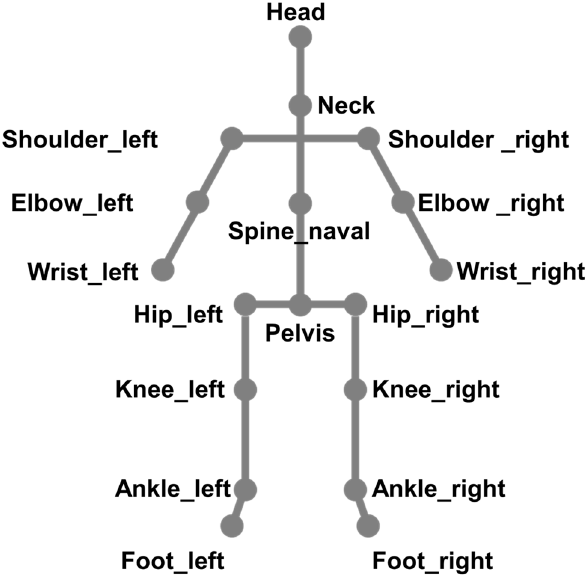
Figure 4. Eighteen types of skeleton data acquired and used for ADHD screening of children.